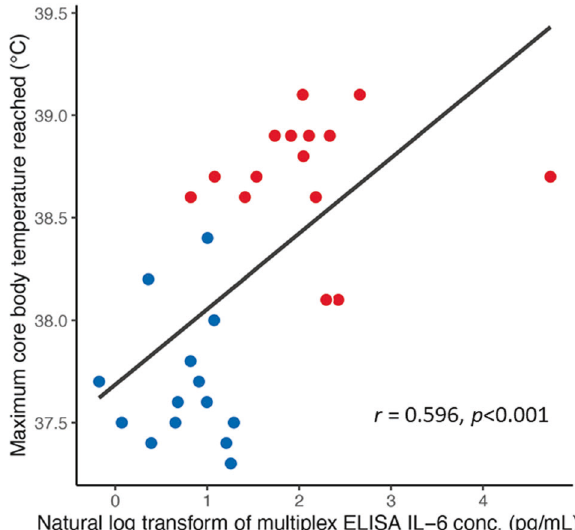
Fig. 3 Correlations between natural log transformed plasma concentrations of interleukin (IL)-6 and maximum core body temperature reached during the experiment. Correlation strength ( r ) and signi fi cance ( p ) accompany the regression line. Red points refer to data measured from participants randomized to the whole- body hyperthermia (WBH) condition, and blue points refer to data measured from participants randomized to the sham WBH condi- tion. C Celsius, ELISA enzyme-linked immunosorbent assay, pg picogram, mL milliliter, WBH whole-body hyperthermia.